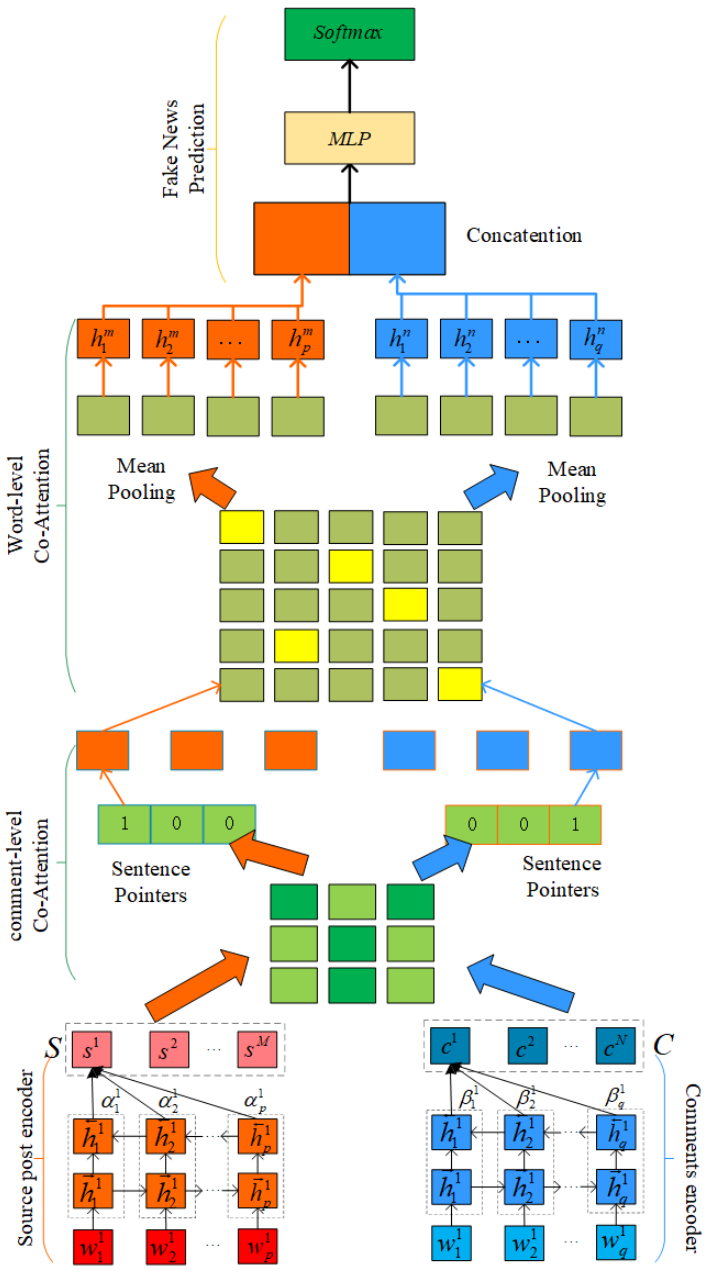
Figure 2. The model of Hierarchical Selection Networks with Co-Attention (HCSN) for interpretable fake news detection following the sequence as